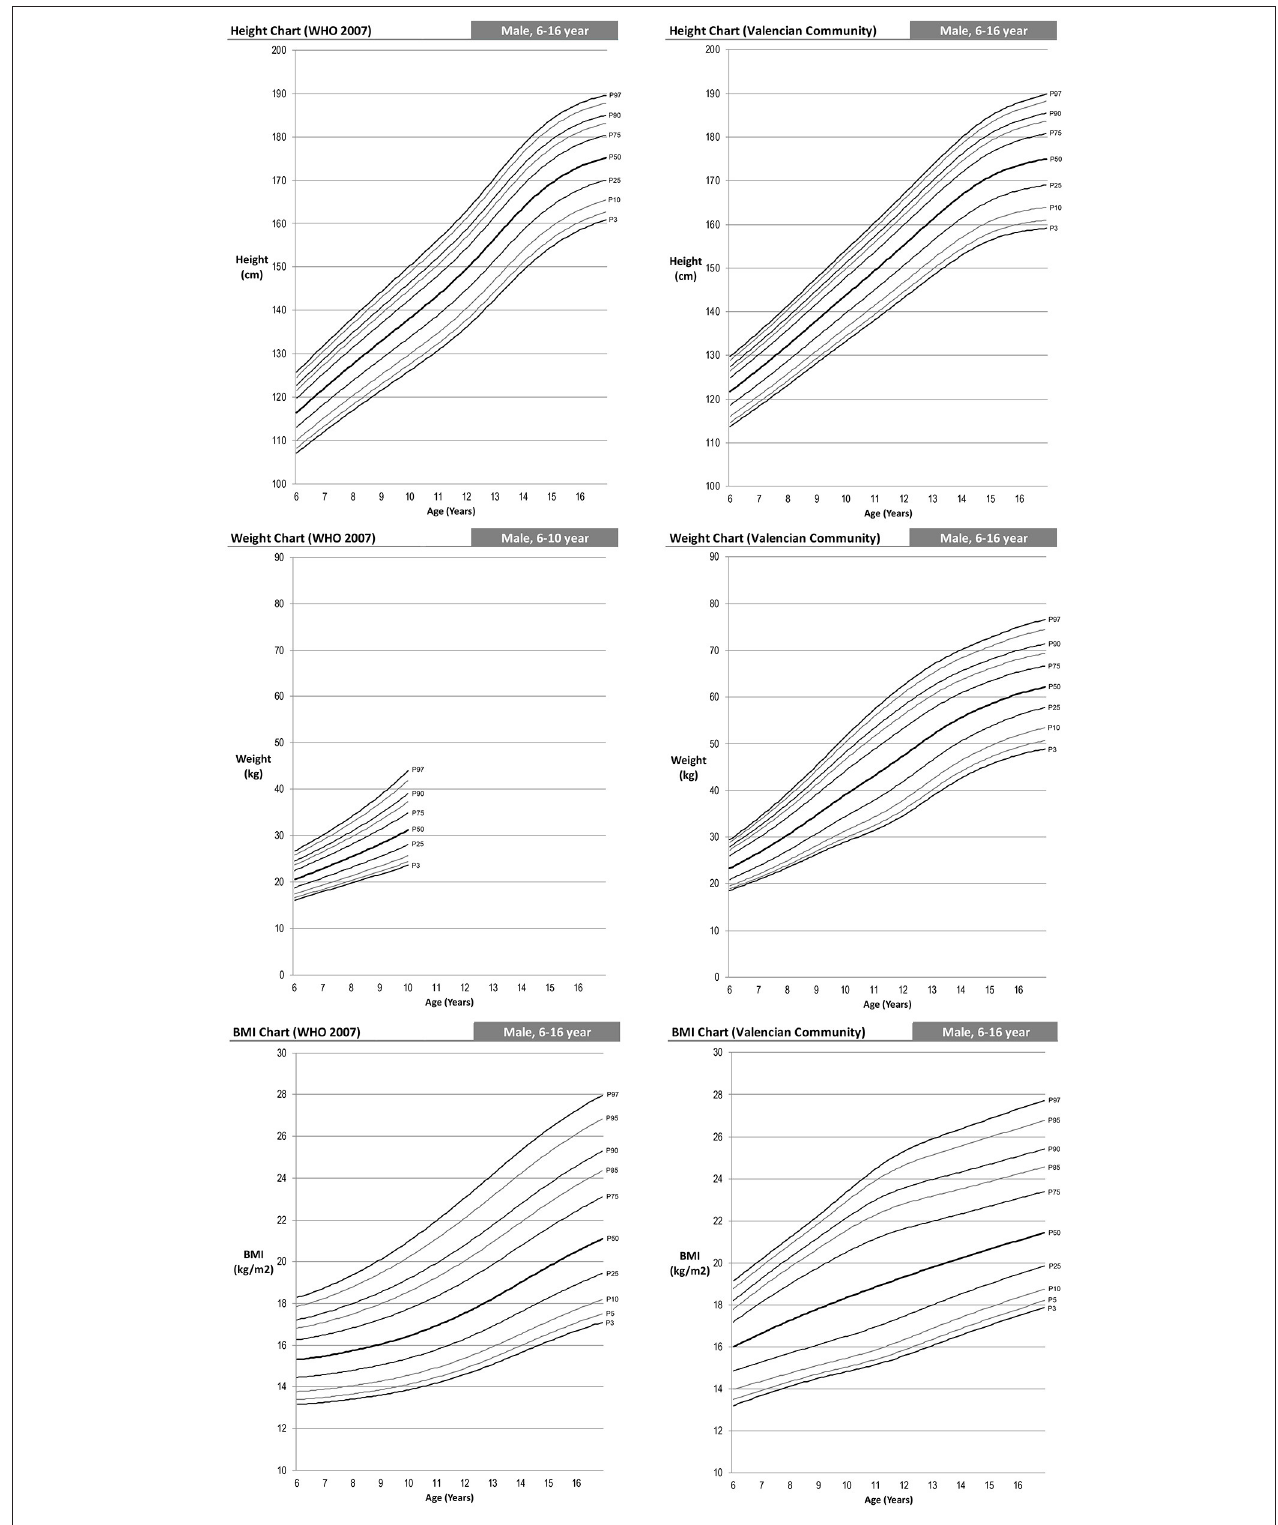
FIGURE 2 | WHO 2007 and Spanish-eastern children male reference